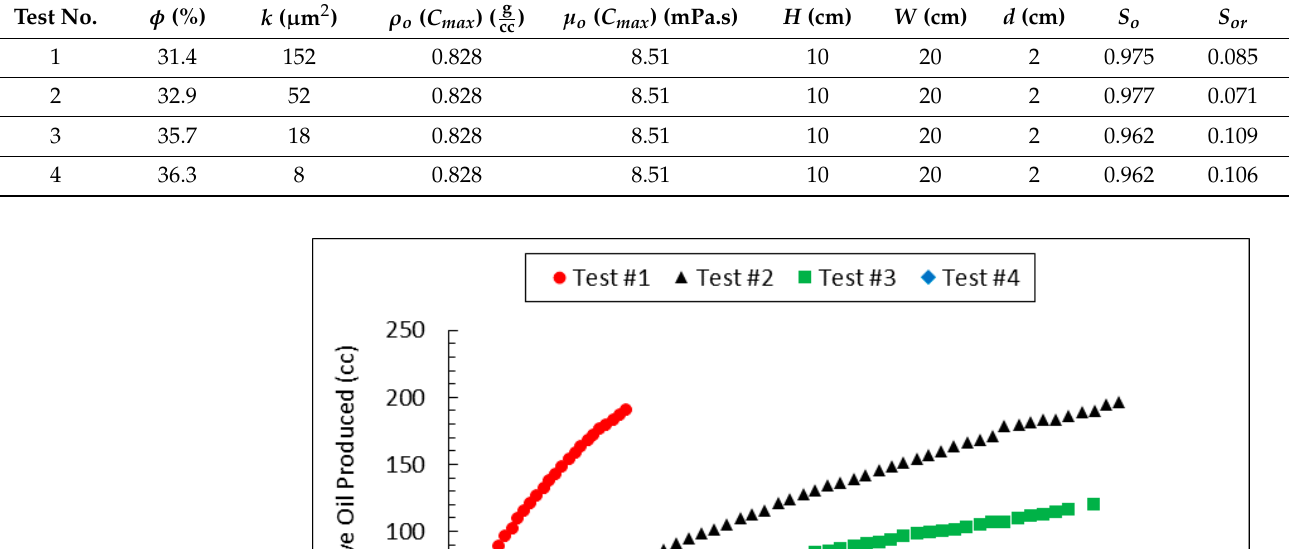
Table 1. Heavy oil and physical model properties for the experimental cases presented by Ma et al. [3].